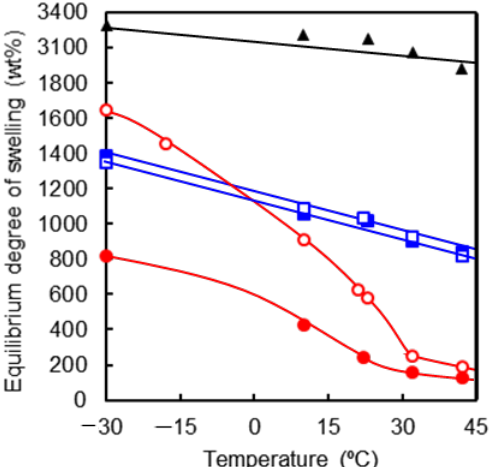
Figure 5. Temperature dependence of the equilibrium degrees of swelling of P1a-gel (red solid circle), P1b-gel (red open circle), P2a-gel (blue solid square), P2b-gel (blue open square), and poly(cyclohexyl methacrylate)-gel (black solid triangle) in chloroform.